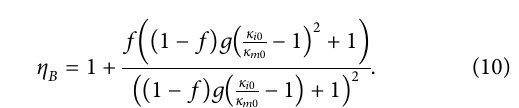
Frontiers in Physics |